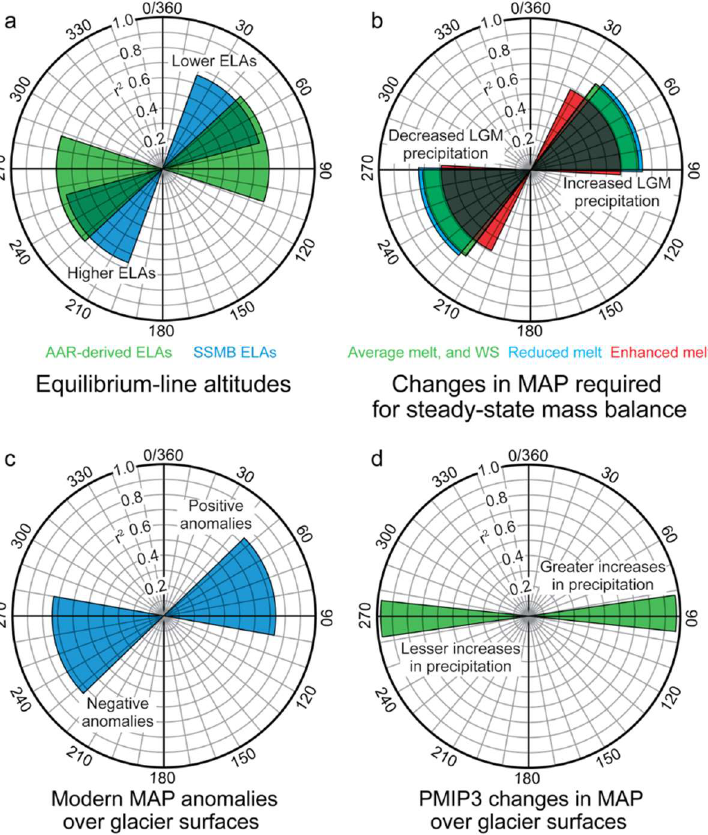
Figure 10. Orientations of maxima and minima obtained by cosinor analyses for ( a ) ELAs, ( b ) changes in LGM MAP required for steady-state mass balances of paleoglaciers for different scenarios, ( c ) mean modern MAP anomalies over glacier surfaces, and ( d ) changes in mean MAP over glacier surfaces suggested by a PMIP3 ensemble. Length of the “petals” correspond to r 2 values. Note that in ( b ), cosinor results are virtually identical for the average melt and winter–spring precipitation scenarios. (See text for details of the scenarios and PMIP3 results).